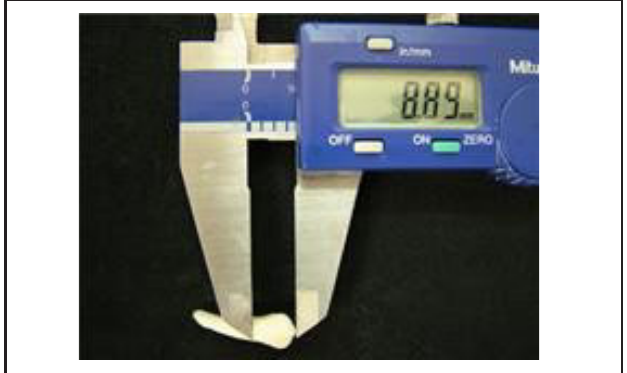
Fig. 3 – Measure of the tooth crown cervico-occlusal height.